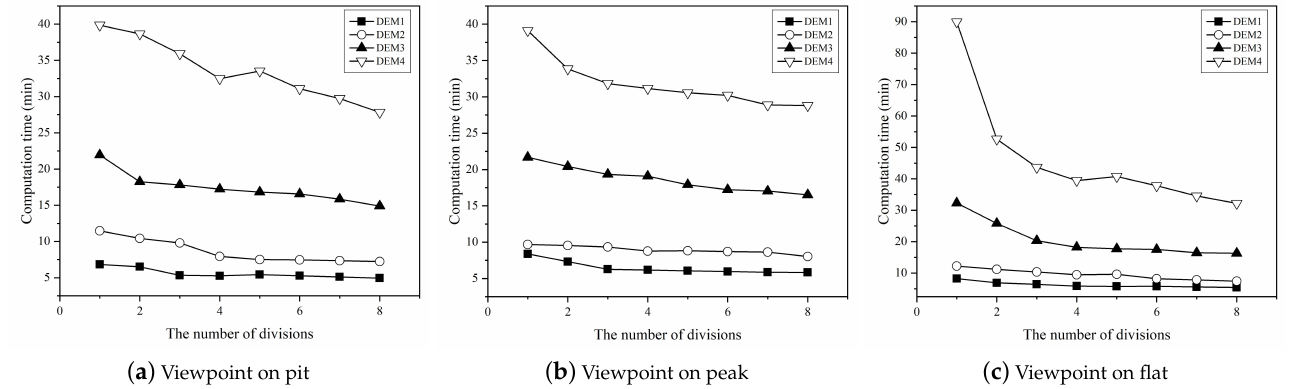
Figure 13. Comparisons of the computation time of different number of